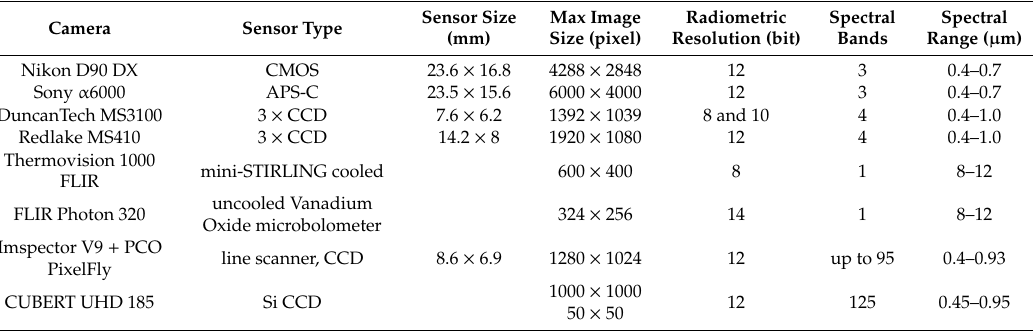
Table 1. The main characteristics of image sensors, number of spectral bands and spectral ranges used within the module for aerial data